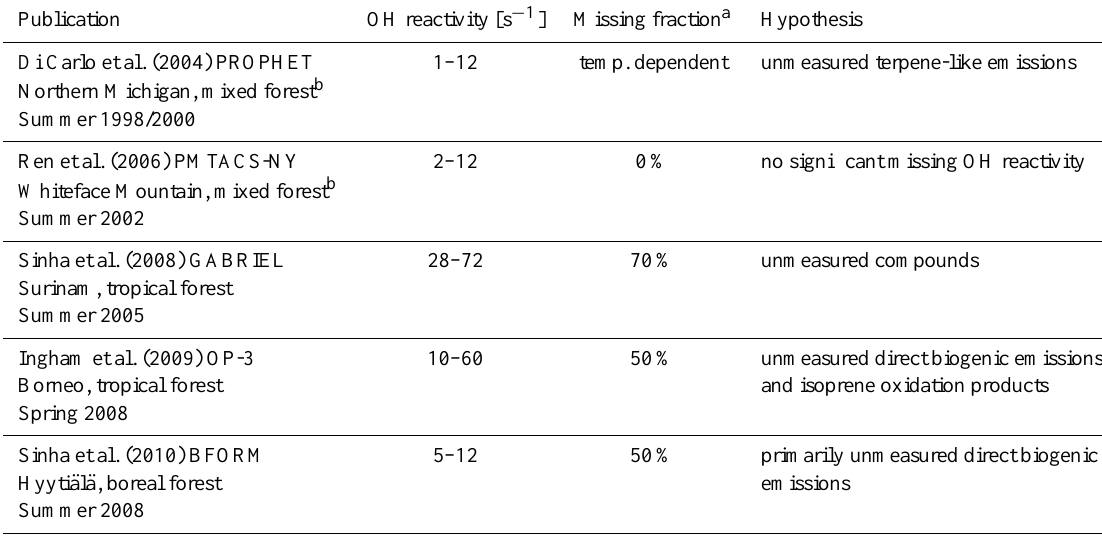
Table 1. Total OH reactivity field studies in forest environments, typical measured values, the mean missing (unexplained) fraction and a hypothesis to explain this missing OH